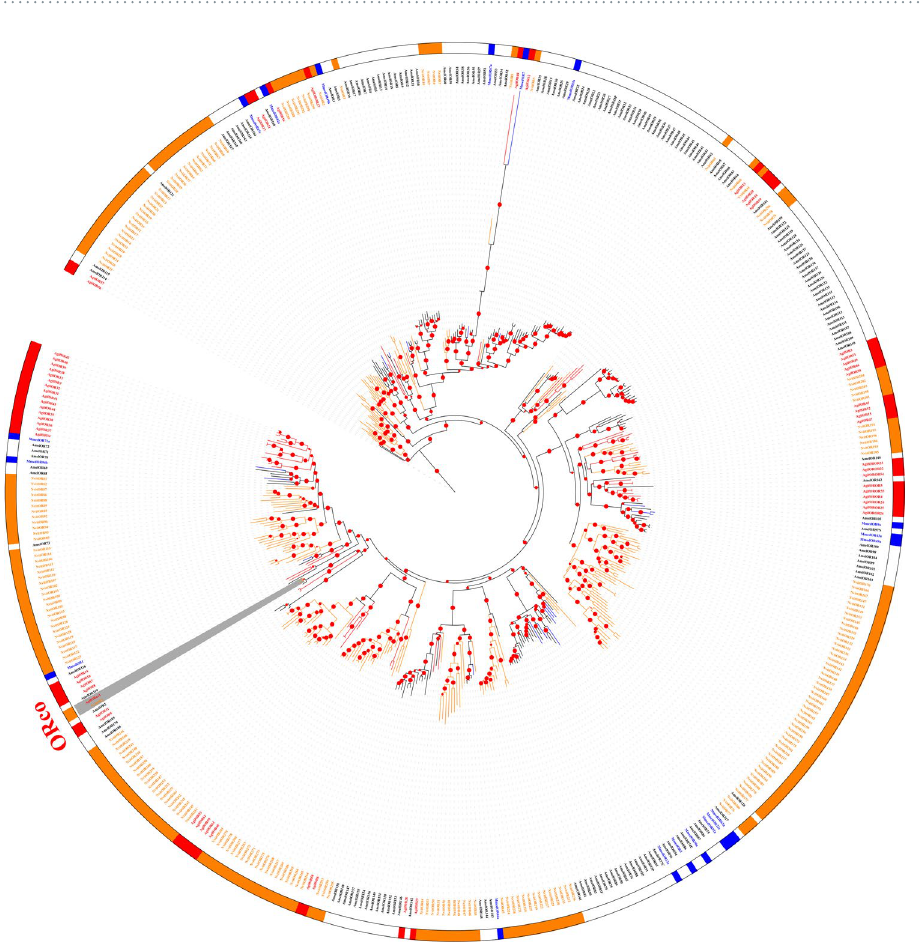
Figure 4. Maximum likelihood phylogenetic tree of odorant receptors (ORs). Included are ORs from Aphidius gifuensis (Agif), Microplitis mediator (Mmed), Apis mellifera (Amel), and Nasonia vitripennis